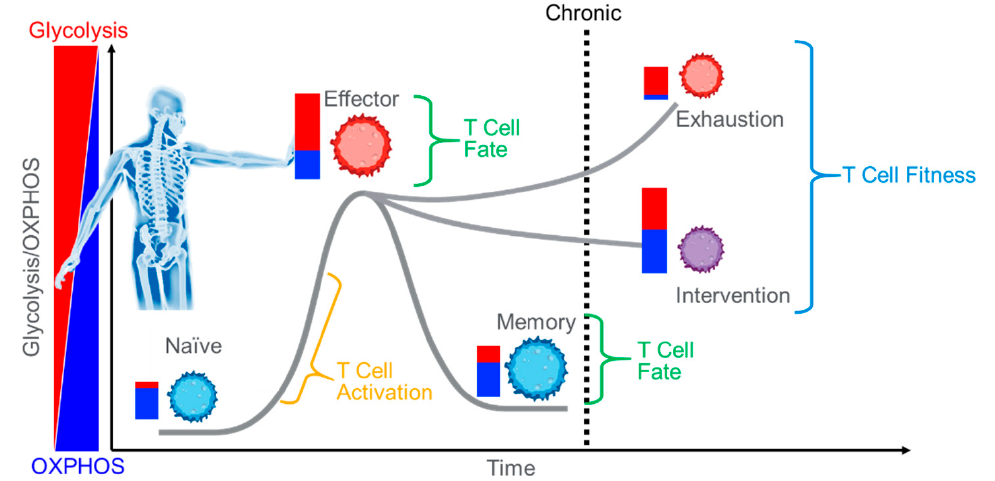
Figure 1. Immunotherapy. Using an individual’s own immune system to fight disease must overcome numerous obstacles such as anergy and exhaustion. Intervention methods often tar- get metabolism. Improving T Cell capacity and efficiency of ATP production is both an approach and a validation